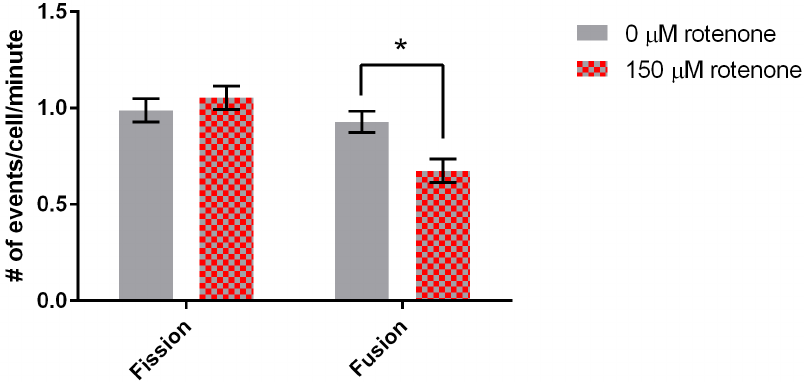
Figure 4. Fission and fusion rates for DMSO and rotenone treated cells. Fission was not significantly affected while fusion decreased 33% when exposed to rotenone ( p = 0.0054), standard error is indicated by error bars ( n = 88). * indicates significant difference between treatments.